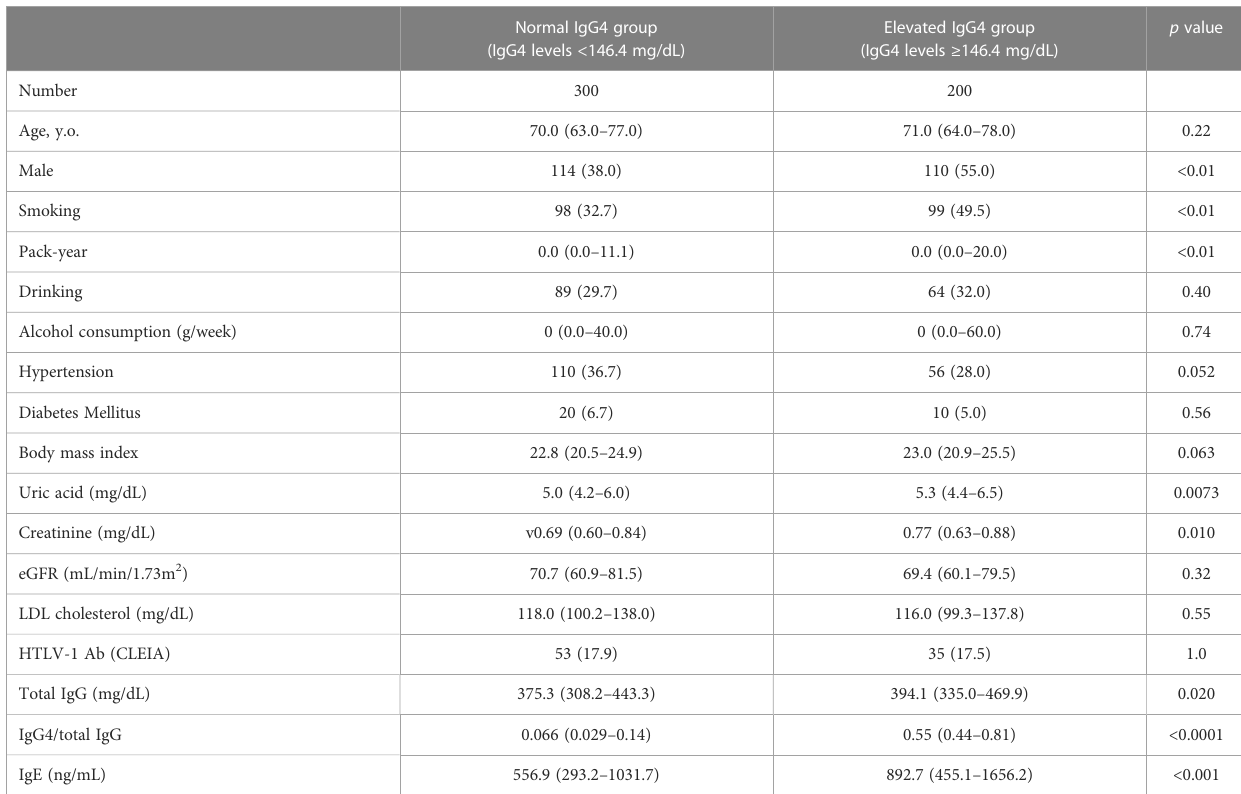
TABLE 2 Univariate analysis strati fi ed by serum IgG4 level and IgG subclass in NaIS.